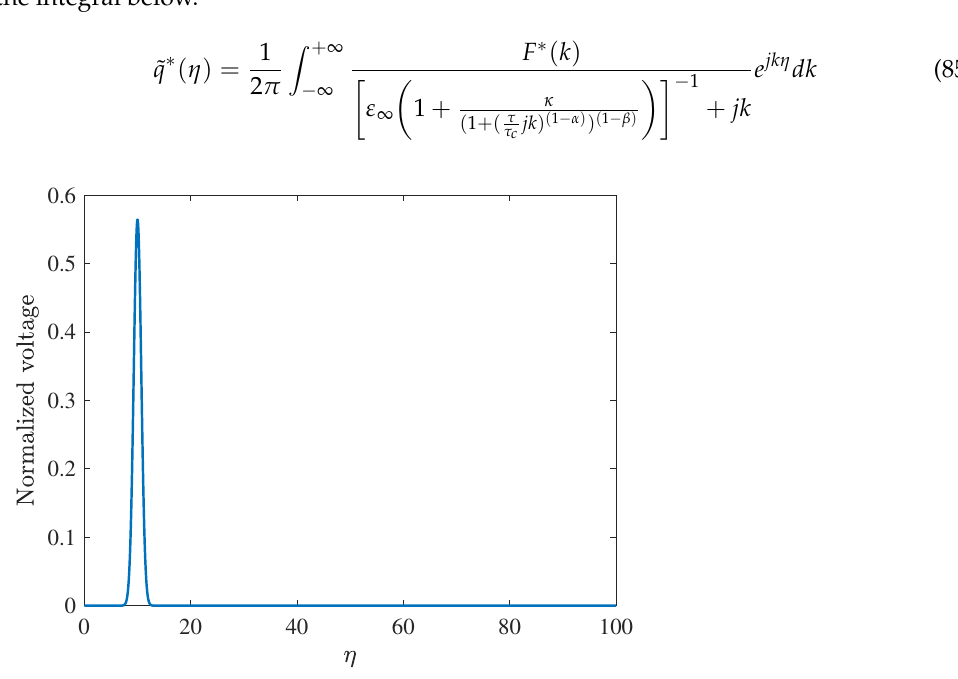
Figure 14. Normalized source